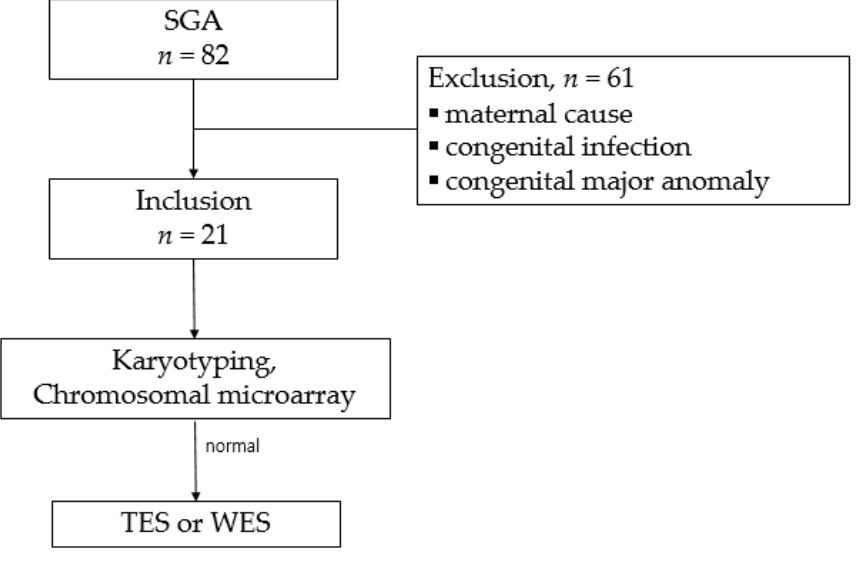
Figure 1. Study selection flowchart.